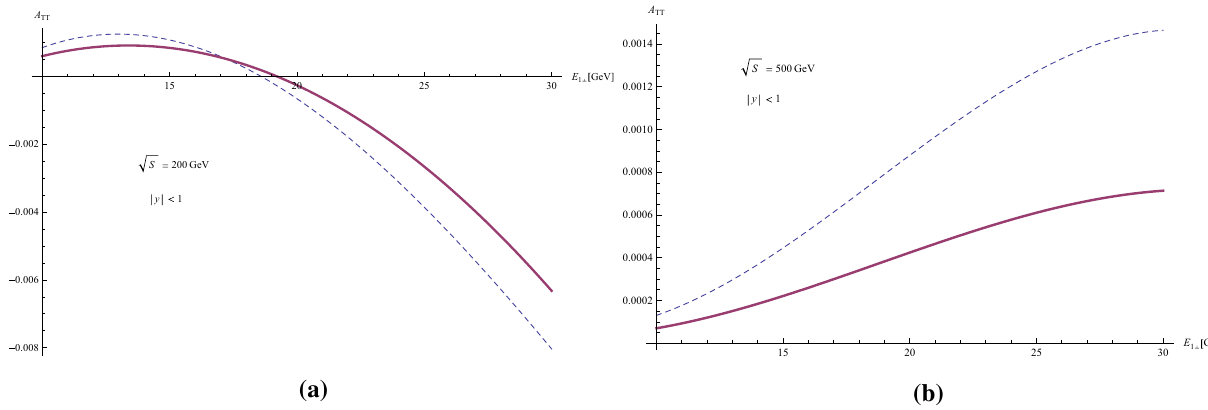
Fig. 7 Azimuthal asymmetries of heavy quark (bottom), in which heavy quark rapidity is integrated over ( − 1 , 1 ) . The dashed line is LO result and the real line is NLO result. The curves are obtained by setting μ = E 1 ⊥